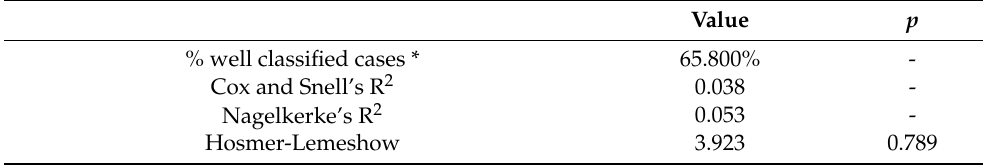
Table 5. Tests on the adequacy of the model. HIV